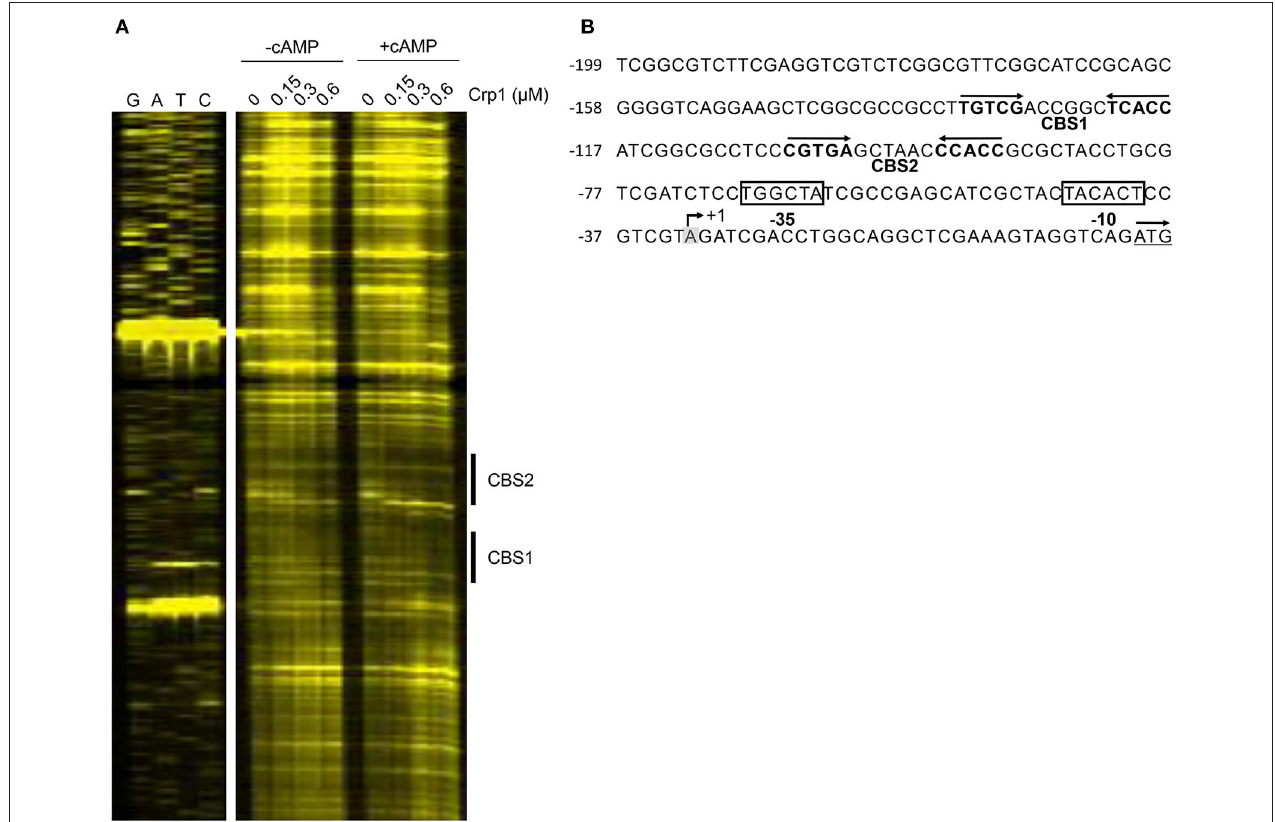
FIGURE 4 | Identification of the Crp-binding sites in the upstream region of cydA . (A) DNase I Footprinting analysis of the cydA upstream region bound by Crp1. The DNA fragments containing the non-coding strands labeled with TAMRA at their 5 ′ ends were incubated with increasing concentrations of purified Crp1 in the absence or presence of 200 µ M cAMP and then subjected to DNase I footprinting reactions. The concentrations of Crp1 used are given above the lanes. The Crp-binding sites (CBS1 and CBS2) are marked by the thick lines on the right. Lanes G, A, T, and C represent the sequence ladders. (B) The upstream sequence of the cydA gene. The Crp-binding sites (CBS1 and CBS2) are marked by the two head-facing arrows above the sequence. The nucleotide reported to be the TSP ( + 1) of cydA is shaded in gray, and the putative − 10 and − 35 elements extrapolated from + 1 are boxed (Aung et al., 2014). The start codon of cydA is underlined and the arrow above it indicates the transcriptional direction. The numbers on the left of the sequences indicate the positions of the leftmost nucleotides relative to the cydA gene. The concentration of Crp1 refers to that of the Crp1